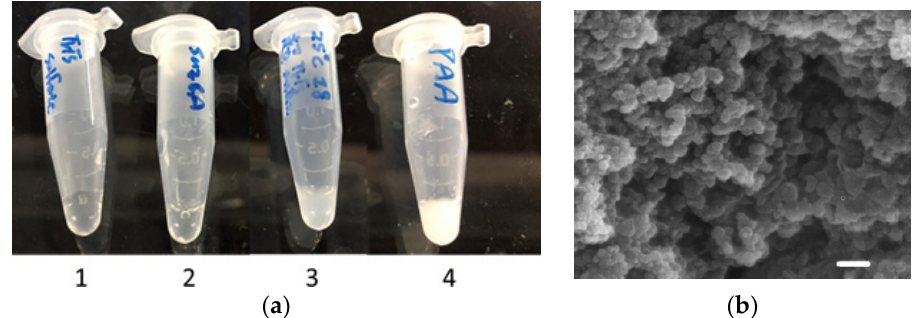
Figure 2. Silica nanoparticles and their morphology. ( a ) The silica-forming ability of the fused R5 peptide. One hundred microliters of freshly prepared silicic acid were mixed with 900 μ L of ( 1 ) storage buffer; ( 2 ) 0.5 mg/mL SazCA in storage buffer; ( 3 ) 0.5 mg/mL R5-SazCA in storage buffer; and ( 4 ) 0.2 mM polyallylamine in storage buffer. Polyallylamine, a common catalyst for biomimetic silica formation, was used as a positive control. ( b ) SEM image of R5-SazCA-SP. The scale bar corresponds to a length of 1 μ m.